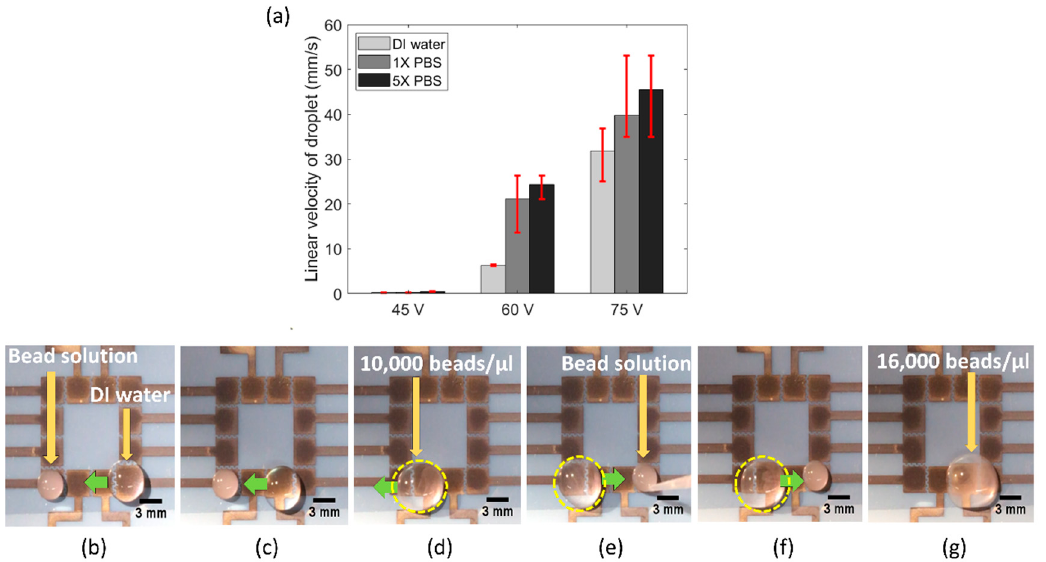
Figure 5 . ( a ) Graph showing a variation of linear droplet velocity at different actuation voltages for buffer I, buffer II and buffer III droplets. ( b ) Position of concentrated bead solution droplet (10 μ L) and buffer I droplet (30 μ L) at time (t) = 9 s. ( c ) Buffer I moves towards the adjacent electrode (t = 12 s). ( d ) Buffer I moves towards the bead solution and mixes with it (t = 18 s). ( e ) A 10 μ L bead solution droplet is again placed on the rightmost electrode (t = 24 s). ( f ) Mixture of bead solution and buffer I moves towards the right electrode (t = 28 s). ( g ) The droplet mixture mixes with the new bead droplet on the rightmost electrode (t = 36 s).